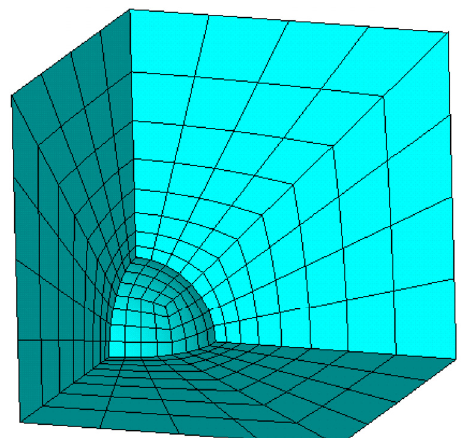
Figure 4: FE model of the single void cell.